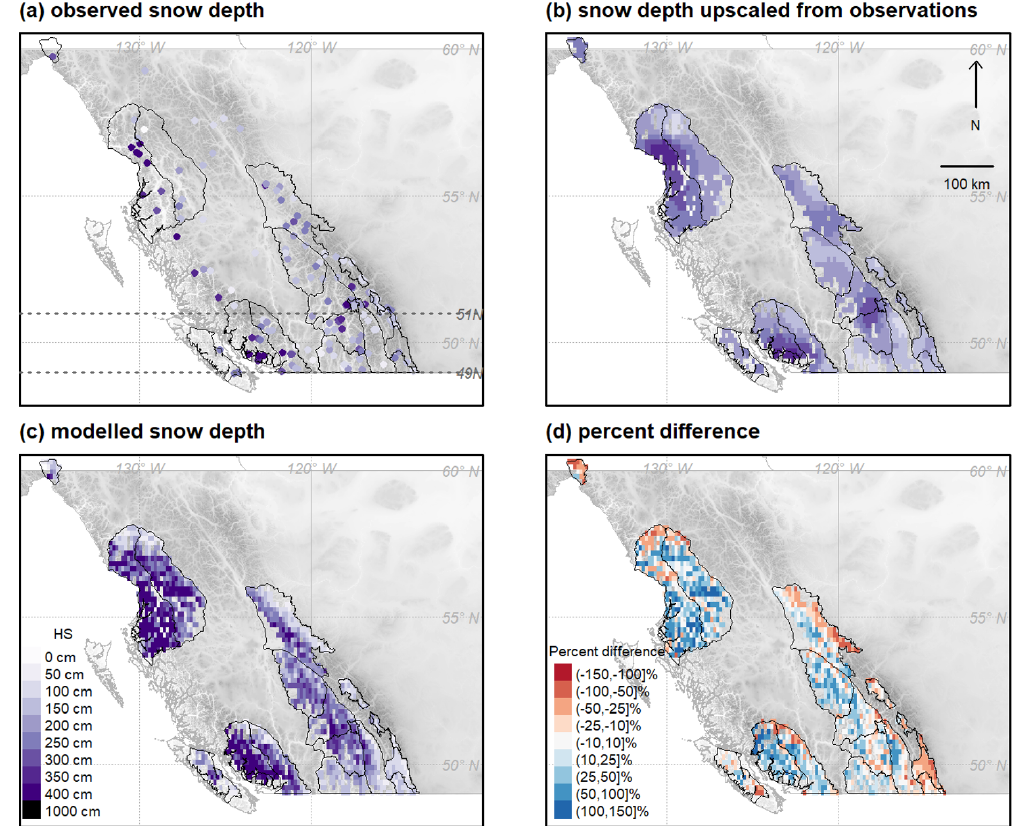
Figure 4. Comparison of observed and modelled snow depths on 31 March 2021 with (a) original snow depths from 176 observations, (b) the observed snow depths upscaled to treeline elevations at 1260 model grid points, (c) the modelled snow depth at the same grid points, and (d) the percent difference between the snow depths from model and upscaled observation data (positive values indicate modelled depths were greater than upscaled observations). Panel (a) shows the latitudinal transect between 49 and 51 ◦ N used in Fig.